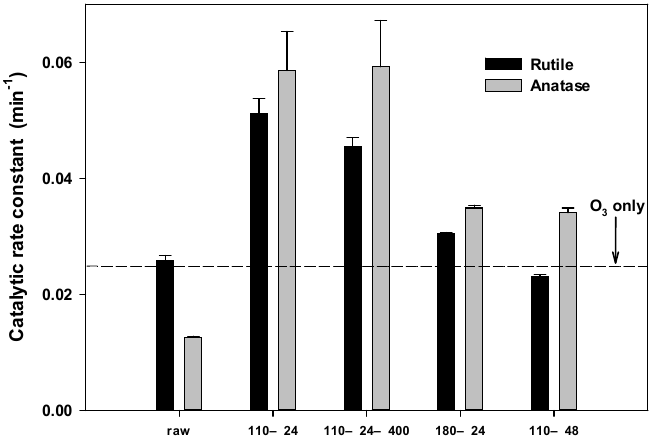
Figure 2. Catalytic rate constants of titania catalysts prepared under different synthesizing condi-